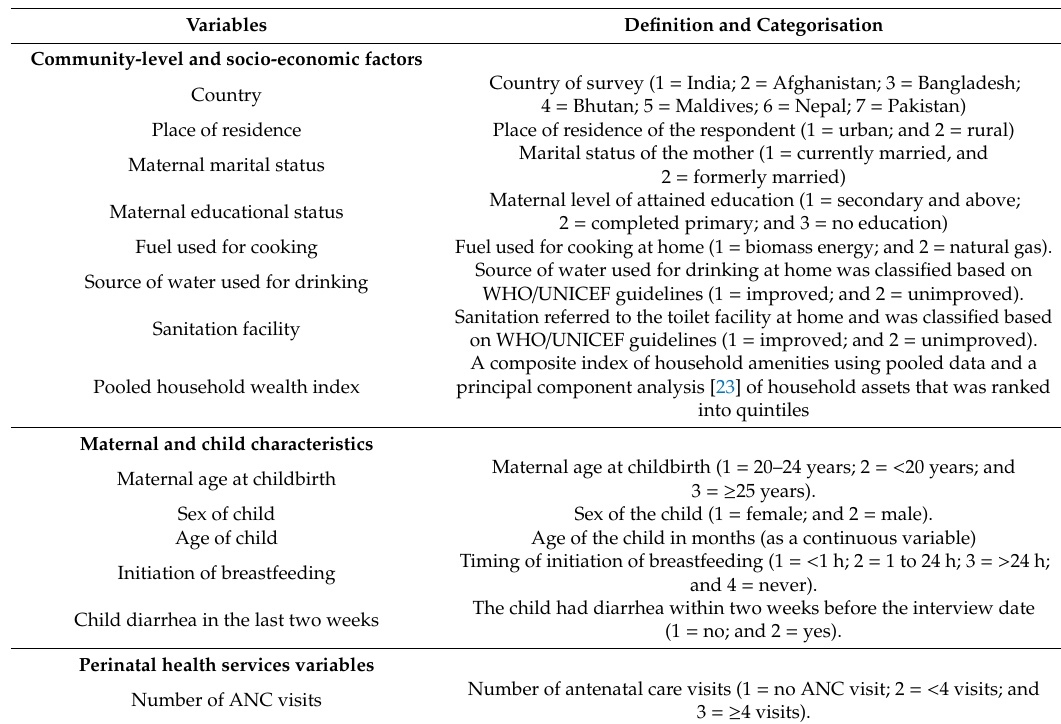
Table 2. Operational definition and categorisation of the potential confounding variables used in the